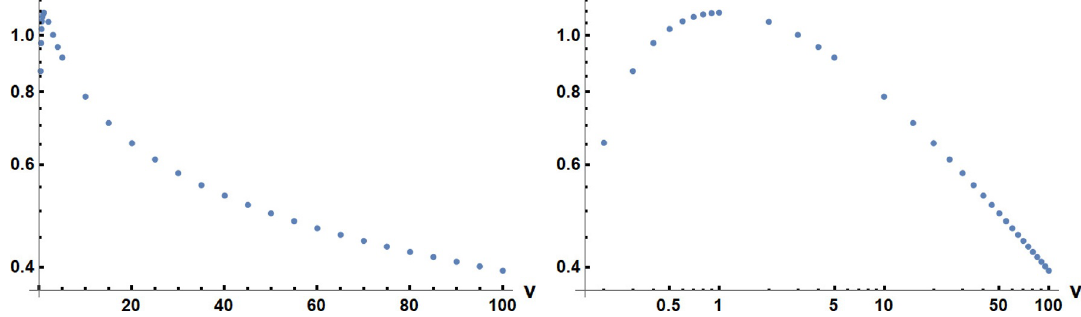
Figure 14 . Ratio of the truncated sum over operators belonging to N 3 over the contribution of all operators N . The right panel is a log-log plot of the same data to highlight the small v ∞